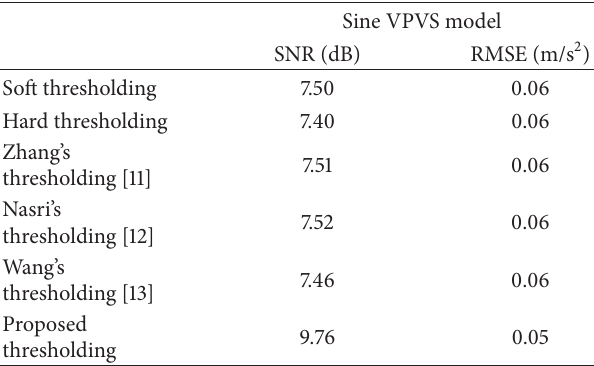
Figure 14: The power spectral analysis of